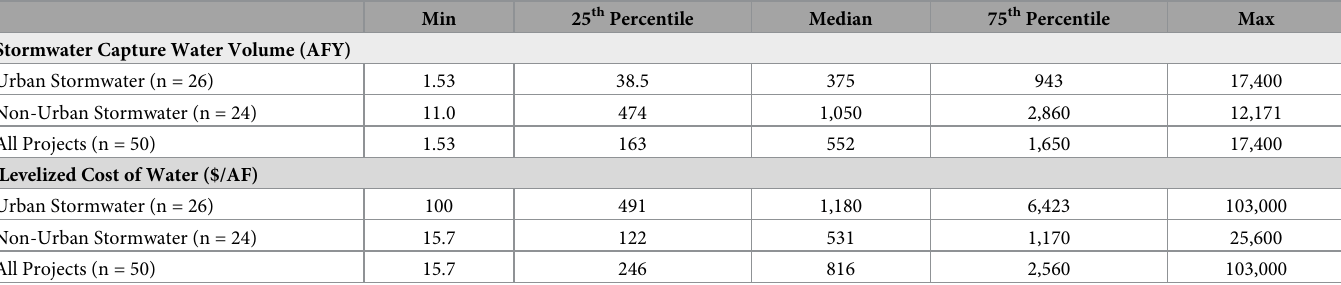
Table 2. Summary statistics describing stormwater water supply yield (AFY) and levelized cost ($/AF) for urban and non-urban stormwater projects.